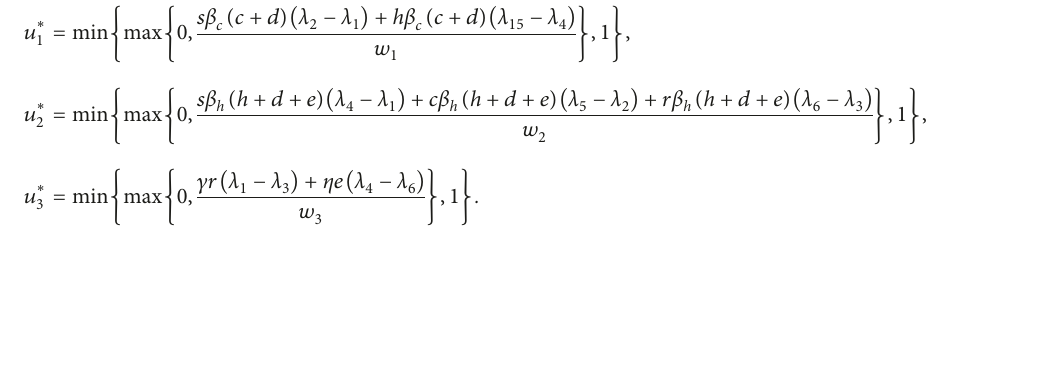
Figure 8: Simulations of co-infected populations with and without